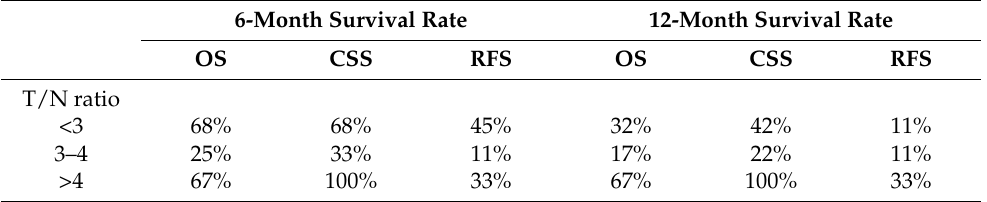
Table 5. Post-BNCT survival rates at the 6- and 12-month time points with respect to the T/N